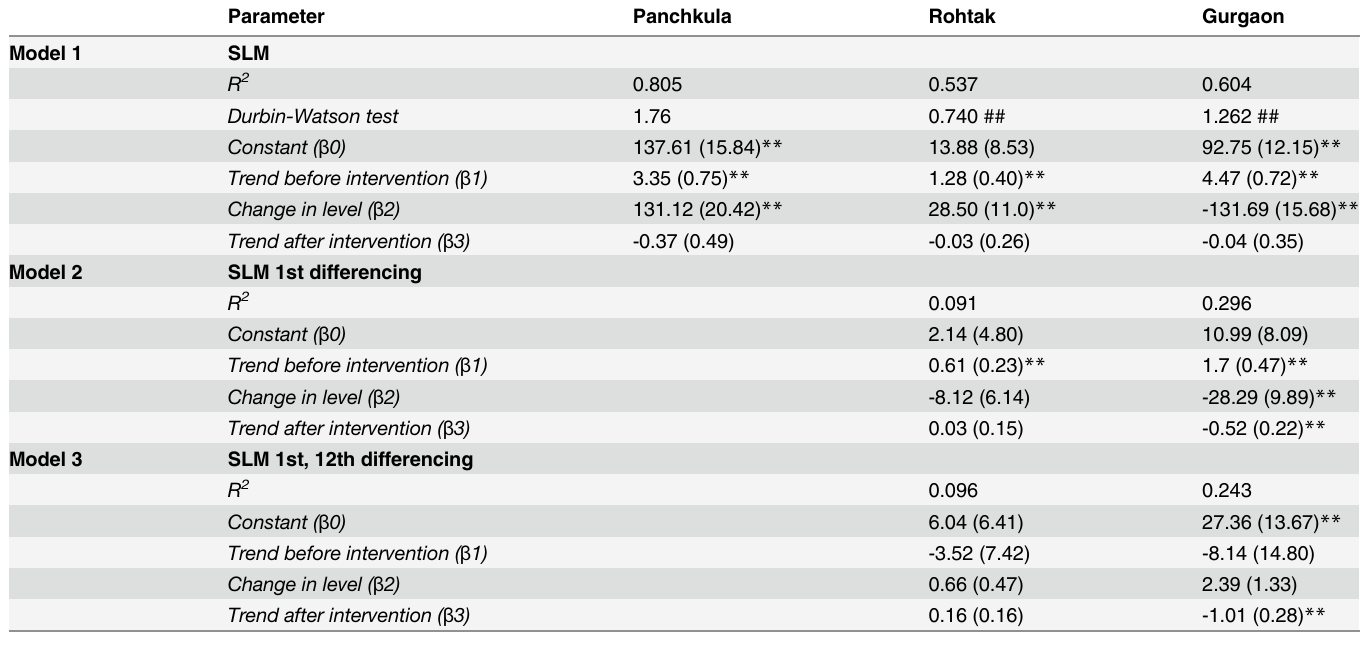
Table 2. Impact of SPP on service utilization at district hospitals in